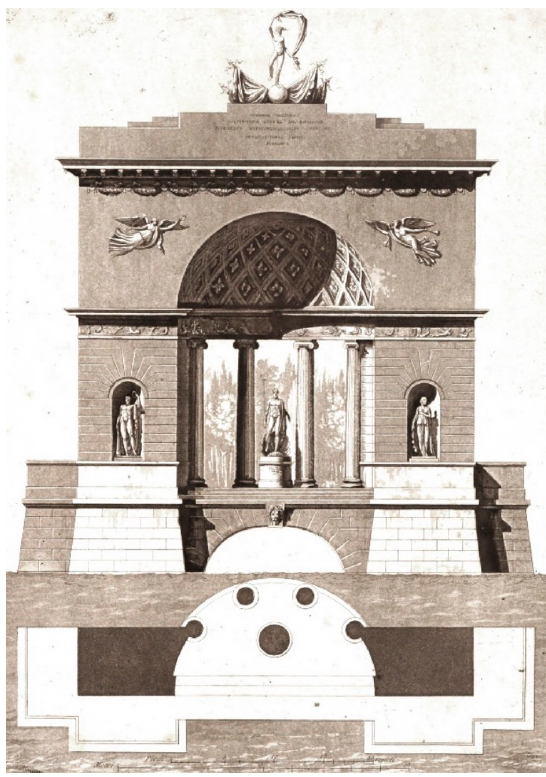
Figure 21. G. Borsato, The Grandstand for the Regatta, engraving, 1807, Museo Correr, Venezia.